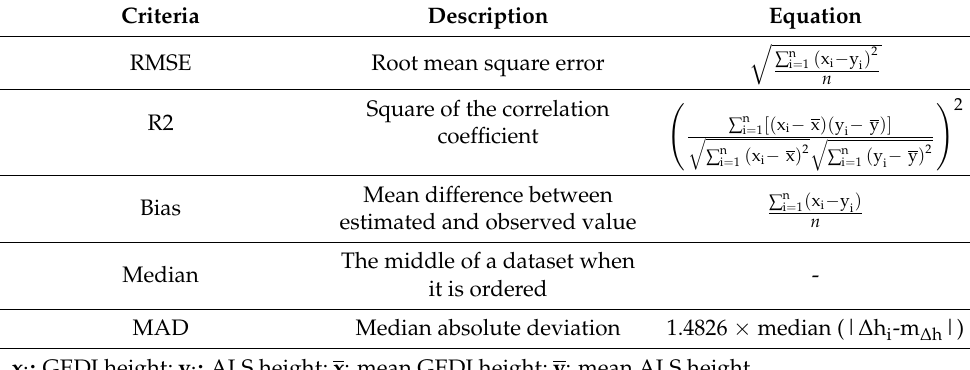
Table 1. Statistic criteria for accuracy assessment of canopy height estimates. Criteria